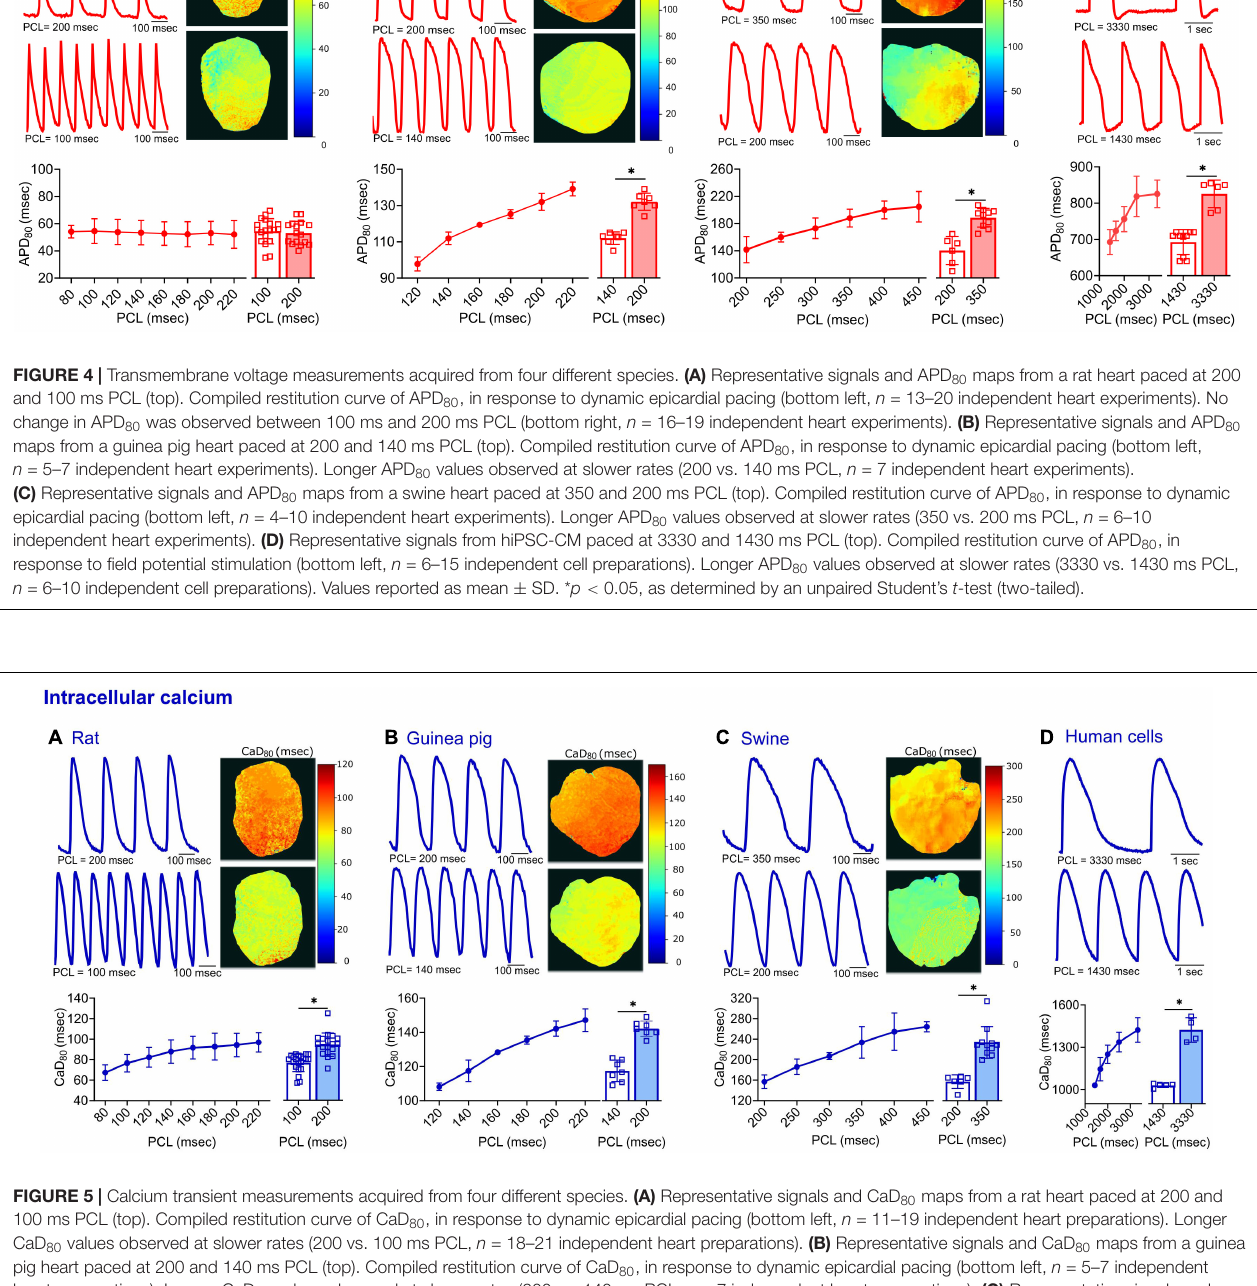
Frontiers in Physiology |